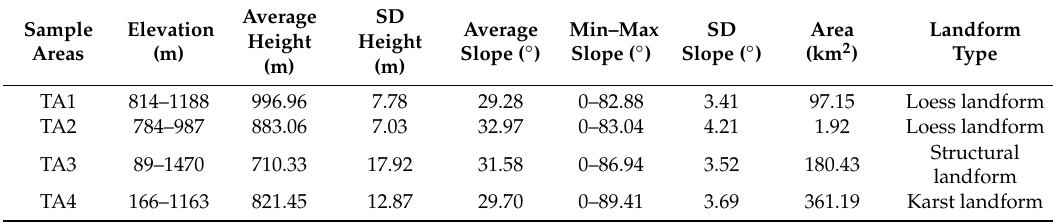
Table 1. Basic information of the three landform